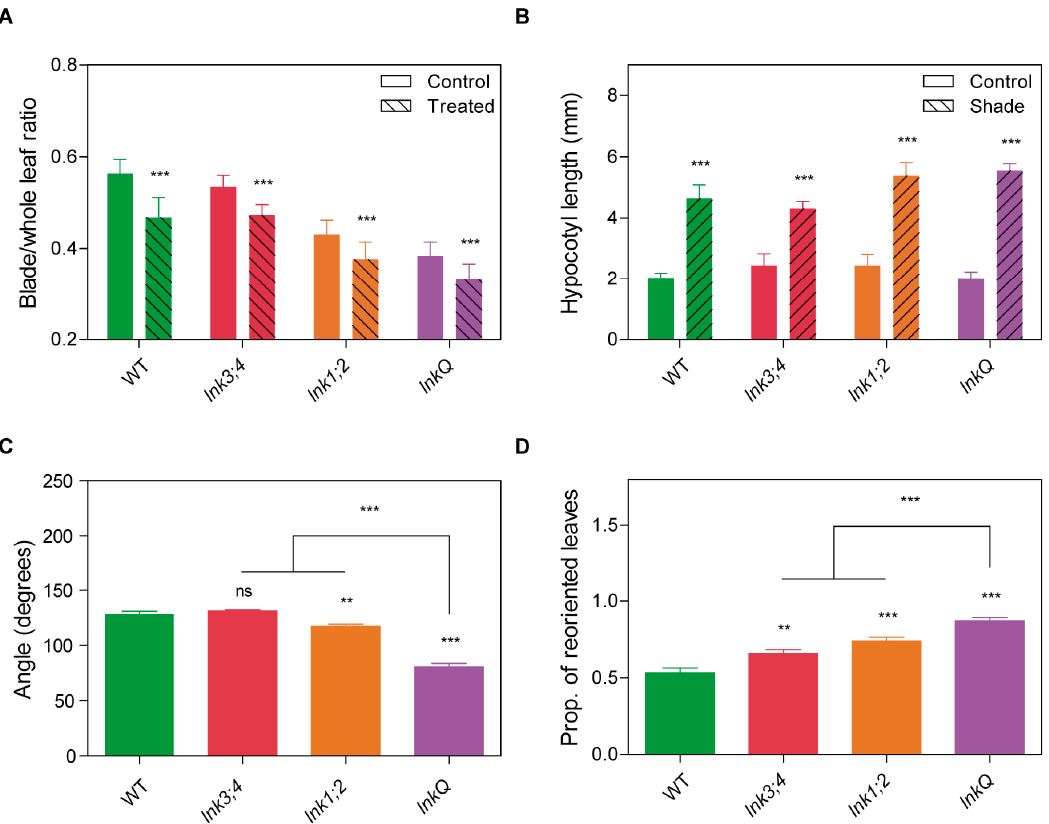
Figure 6. lnkQ mutants displayed normal shade avoidance but enhanced phototropic responses. Shade avoidance responses in WT plants and in lnk mutants. ( a ) Blade to whole leaf length ratio of the eighth leaf was determined in plants grown in long days and treated or not (control) with a far-red pulse of fifteen minutes after lights went off (end-of-day far-red treatment). ( b ) Hypocotyl length of seedlings grown in white light or white light with an end-of-day far-red treatment. ( c ) For the analysis of leaf angles in adult plants, six-week old plants grown in a short-day photoperiod were photographed from the side. The angle between two opposing leaves closest to the light source was measured. ( d ) The proportion of leaf blades perpendicular to the light source was determined in plants grown in long days with vertical illumination until the first pair of leaves appeared, and then exposed to a lateral light source until the plants developed 8–10 leaves. Error bars indicate SEM. Student’s t -test was performed between mutants and WT (*: significantly different, p ≤ 0.05; **: significantly different, p ≤ 0.01; ***: significantly different, p ≤ 0.001; ns: not significant).